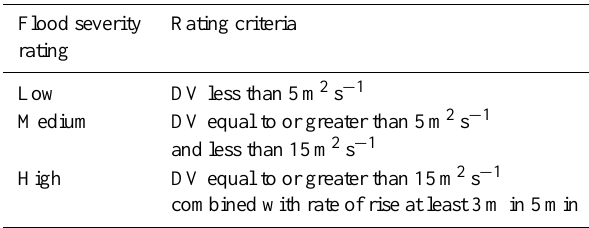
Table 1. Flood severity rating criteria (source: Department of Homeland Security (DHS),